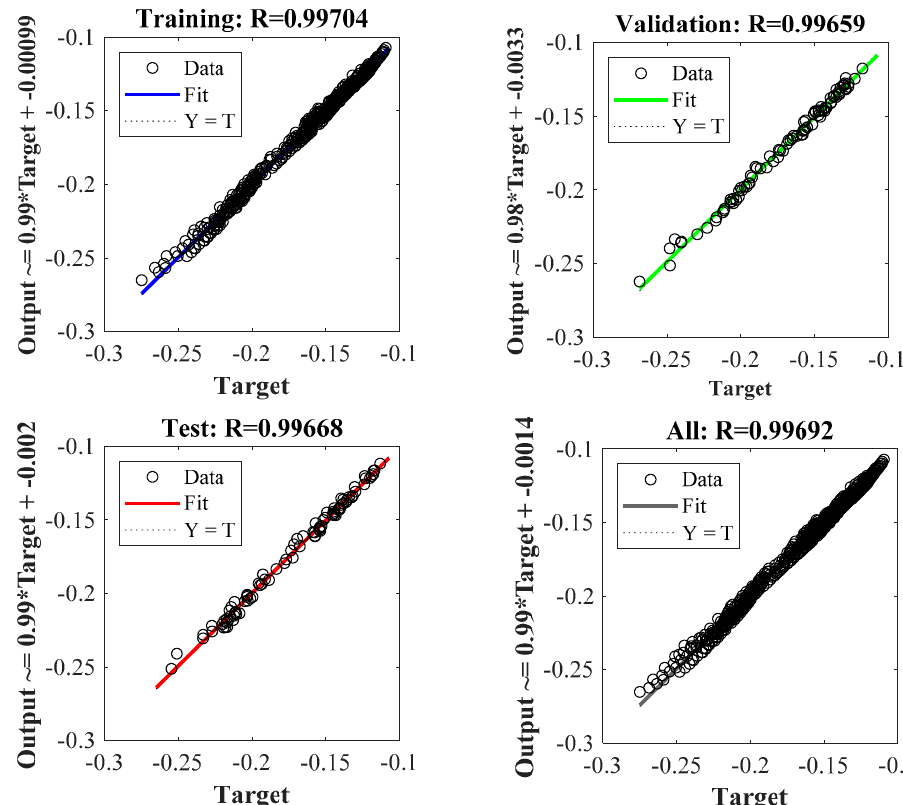
Figure 12. Fitting data from the regressed model and original